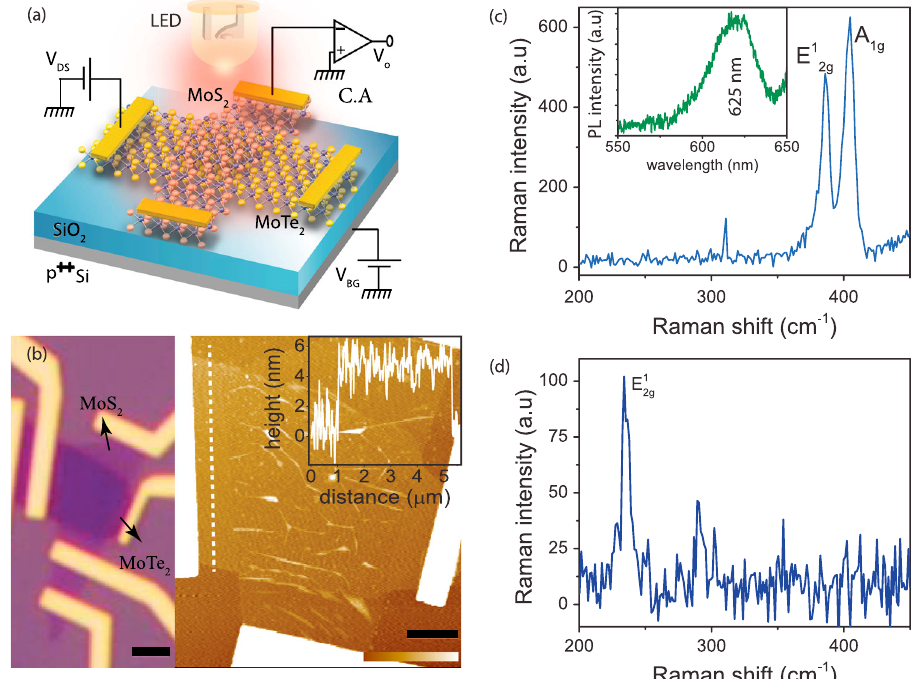
Fig. 1 a Schematics of the device, with the experimental setup. Bias ( V DS ) was applied to MoTe 2 fl ake and current output was measured with a current ampli fi er (CA) connected to MoS 2 fl ake. Gate voltage ( V BG ) was applied to P ++ Si of the substrate. LED was used to illuminate the sample for opto-electronics measurements. b Optical image ( left ) and AFM image ( right ) of the device. The scale bar ( black ) for optical and AFM images are, respectively, 2 μ m and 1 μ m. The color scale bar for AFM image is 85 nm. Inset is MoTe 2 height pro fi le along the dashed line . c Raman and PL ( inset ) of MoS 2 . d Raman for MoTe